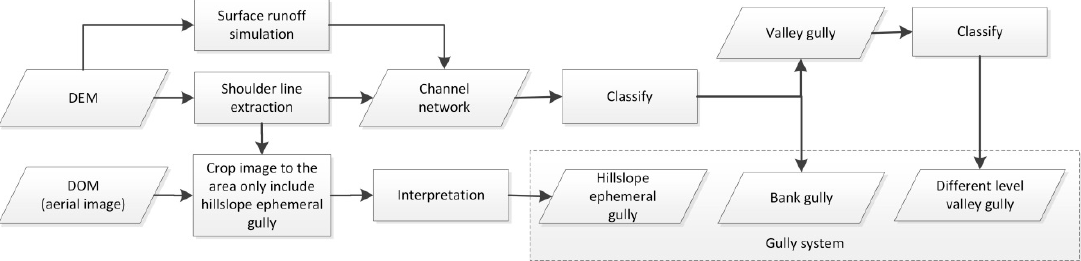
Figure 4. Workflow of gully system extraction.